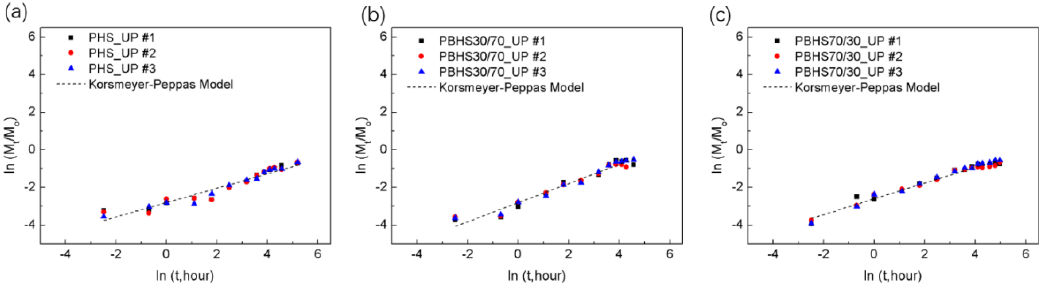
Figure 9. Simulation of initial release at 25 °C. ( a ) PHS_UP samples; ( b ) PBHS30/70_UP samples; ( c ) PBHS70/30_UP samples. Table 4. Simulation using Korsmeyer-Peppas